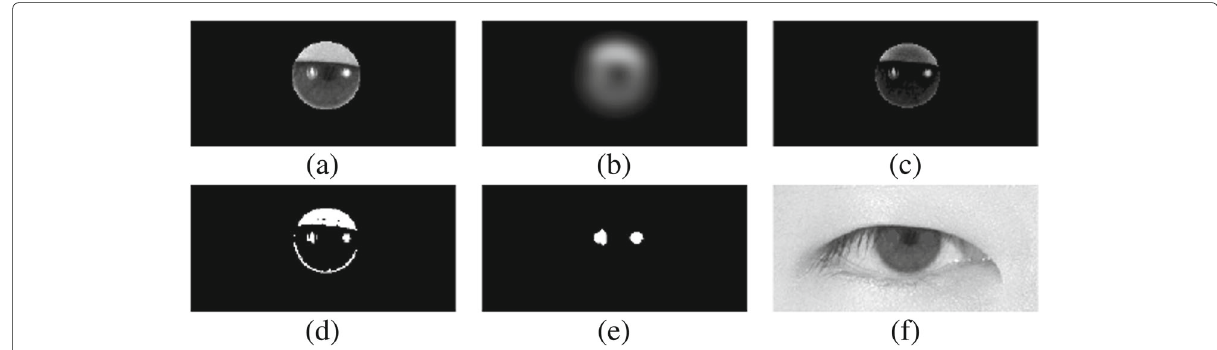
Fig. 4 Specular reflections removal. Iris boundary mask applied to the eye sub-image ( a ), Gaussian filtering ( b ), Gaussian difference ( c ), specular reflections thresholding ( d ), blobs corresponding to specular reflections ( e ) and eye after specular reflections removal ( f